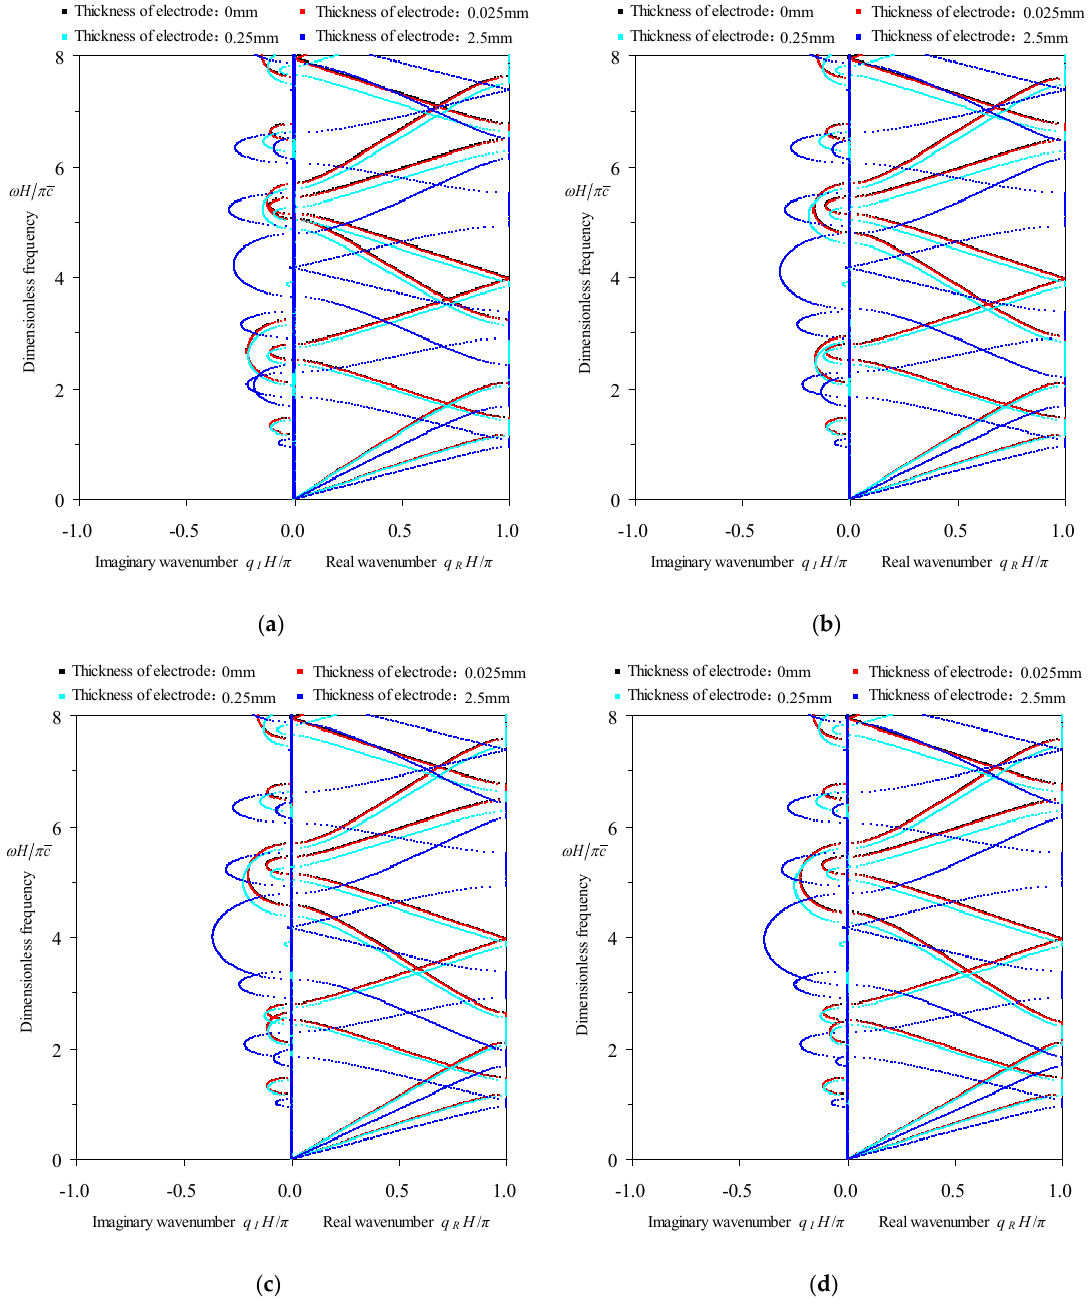
Figure 4. The effect of Brass electrode thickness on the wavenumber spectra of periodic Glass-Brass-(PZT-5H 1 )-Brass multilayers in cases of four electrical boundaries: ( a ) Electric-open condition; ( b ) Applied C / S = 1.02 pF/mm 2 condition; ( c ) Electric-short condition; ( d ) Applied K g = 5.0 × 10 8 V/m